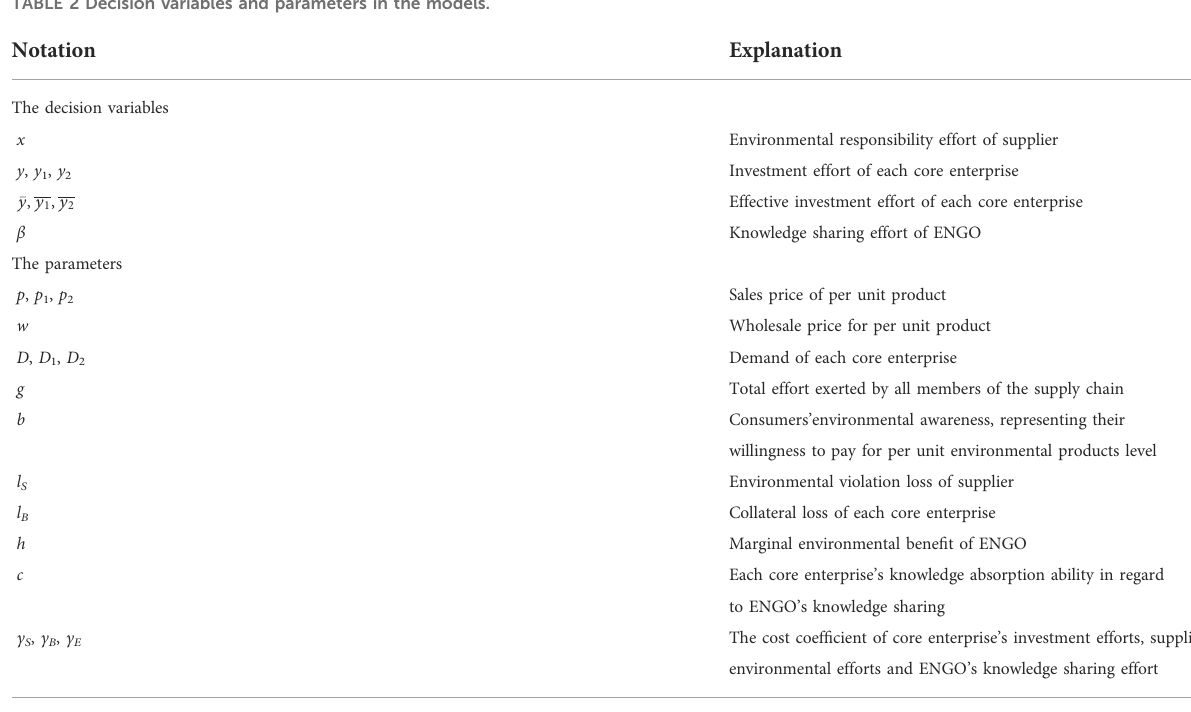
TABLE 2 Decision variables and parameters in the